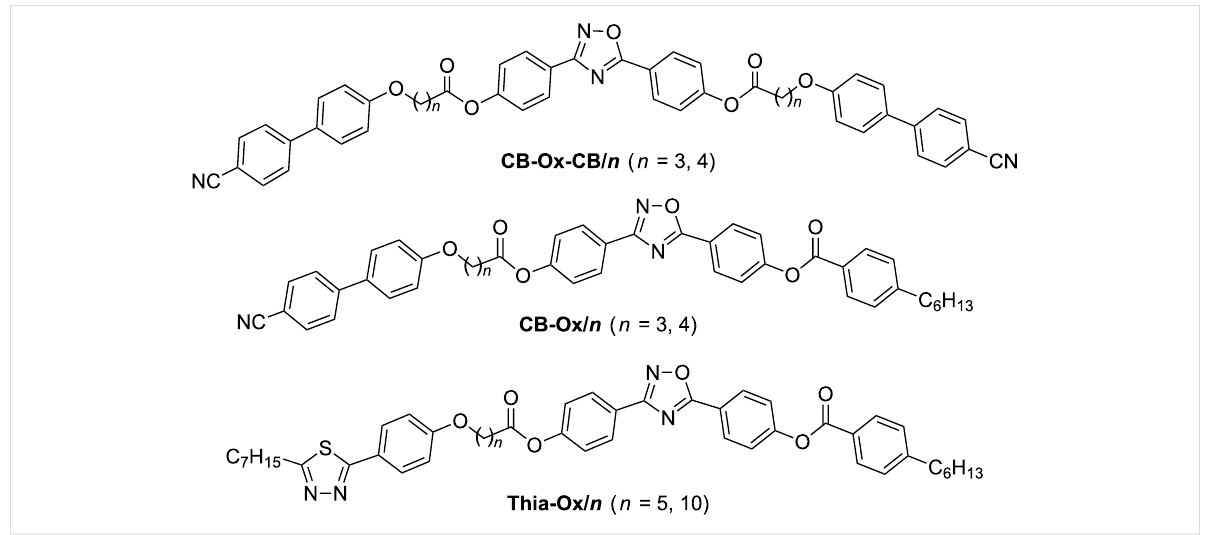
Scheme 1: Structures of the investigated ABA-heterotrimesogens CB-Ox-CB/ n and heterodimesogens CB-Ox/ n , Thia-Ox/ n